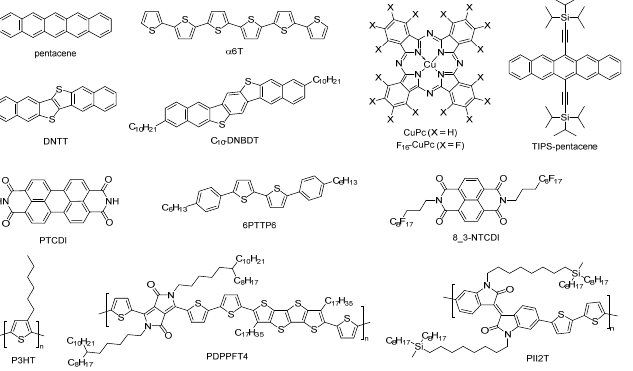
Figure 4. Chemical structures of small-molecule and polymeric semiconductors used for OFET tem- perature sensors. temperature